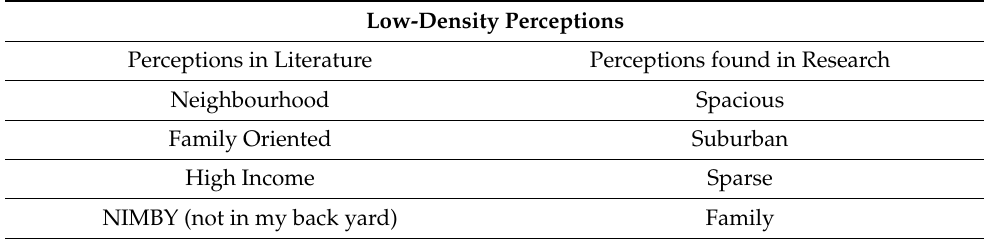
Table 4. Density Perceptions Comparison .